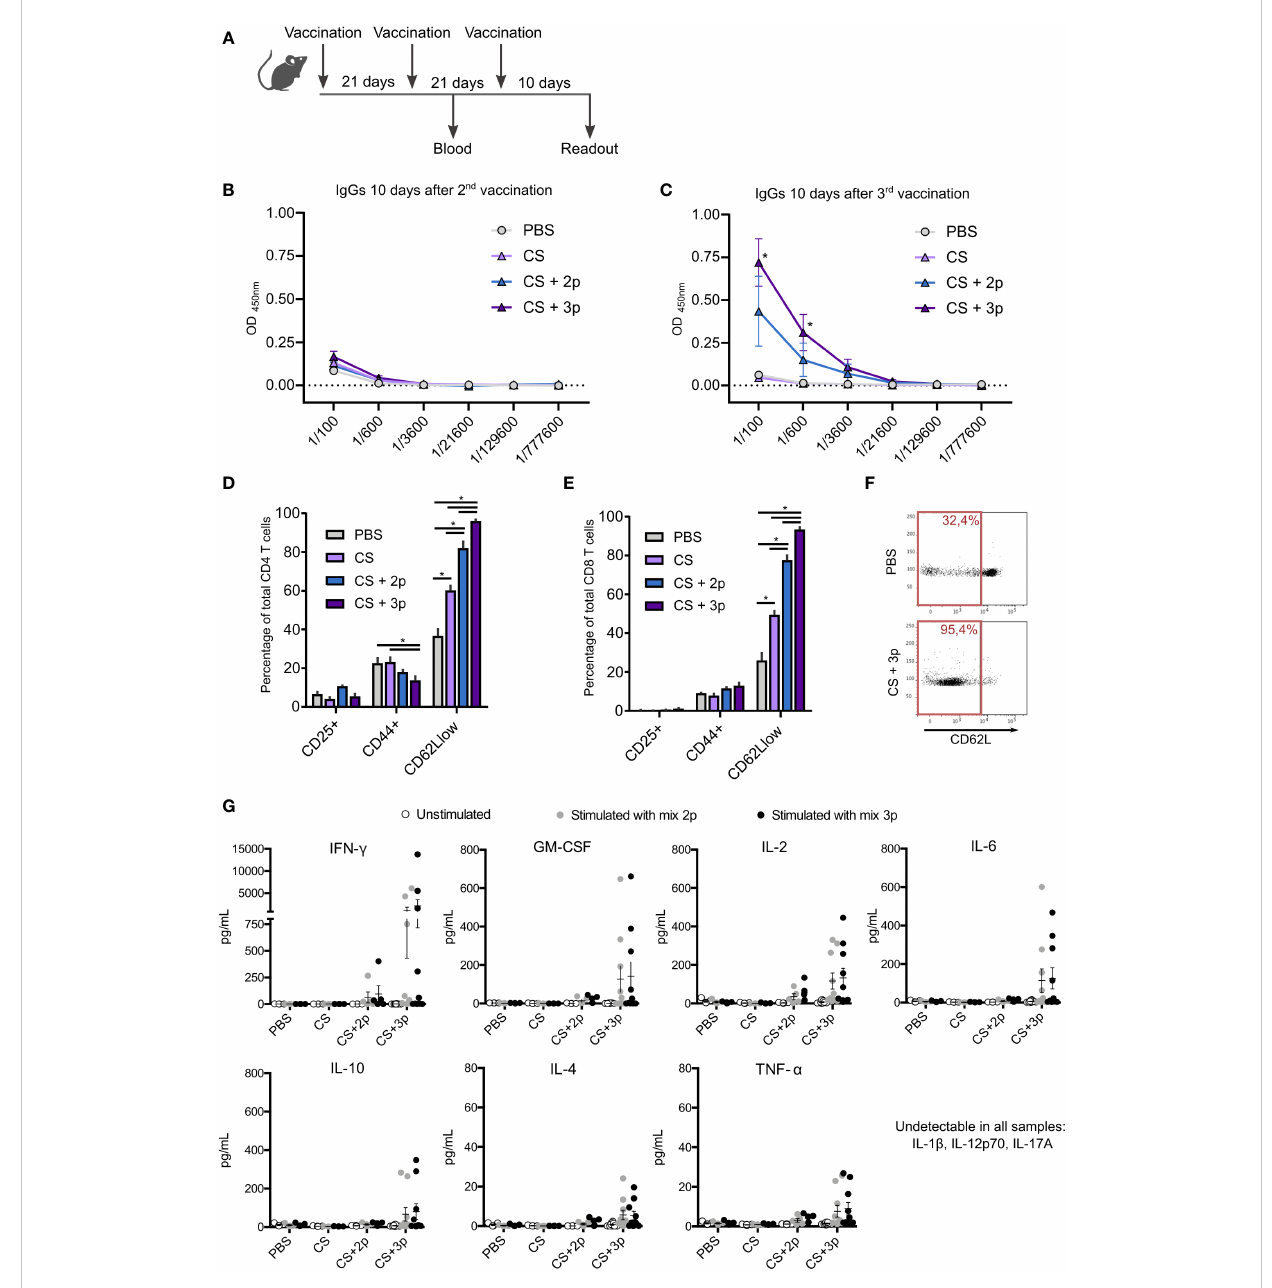
FIGURE 1 Characterization of the immune response generated by CS-Krasm vaccines. (A) Vaccination regimen is depicted. C57BL/6 mice 8-weeks old were vaccinated three times at 21-day intervals (n=5-10 per group). Blood was collected 10 days after 2 nd and 3 rd immunization. Ten days after 3 rd immunization, mice were sacri fi ced, and spleens were collected. The levels of speci fi c IgGs that recognize a mixture of Krasm peptides (peptide 1, peptide 2 and peptide 3) were determined by ELISA immunoassay using serum collected ten days after the 2 nd (B) and 3 rd (C) immunization. Splenocytes were cultivated for 72 hours with the 3-peptides mixture. Then, lymphocyte biomarkers were evaluated by fl ow cytometry in CD4 T (D) and CD8 T cells (E) . Kruskal – Wallis and Dunn ’ s multiple comparison test were used for statistical analysis. *p < 0.05. (F) Representative example of the fl ow cytometry dot plot showing CD62L expression in PBS-vaccinated mice and CS+3p-vaccinated mice, with their respective percentages of CD62L low-expressing cells from ancestor gate. (G) Splenocytes were left unstimulated or incubated with either the 2-peptides mixture (peptide 1+ peptide 2) or the 3-peptides mixture (peptide 1 + peptide 2 + peptide 3) for 72 hours. Supernatants were collected and levels of cytokines GM-CSF, IFN- g , IL-2, IL-4, IL-6, IL-10, TNF- a , IL-1 b , IL-12p70 and IL-17A were measured using a multiplex cytokine